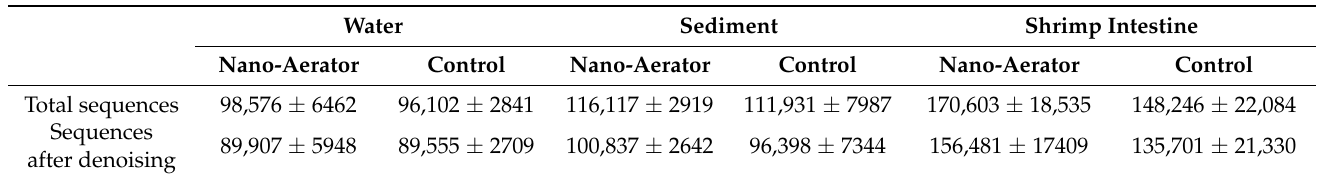
Table 1. Sequence after denoising in water, sediment, and shrimp intestinal samples under the action of nano-aerator and